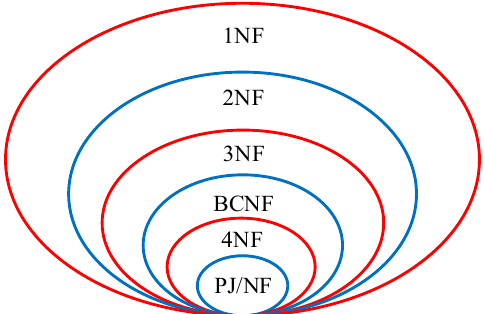
Figure 14. Regularization hierarchy.